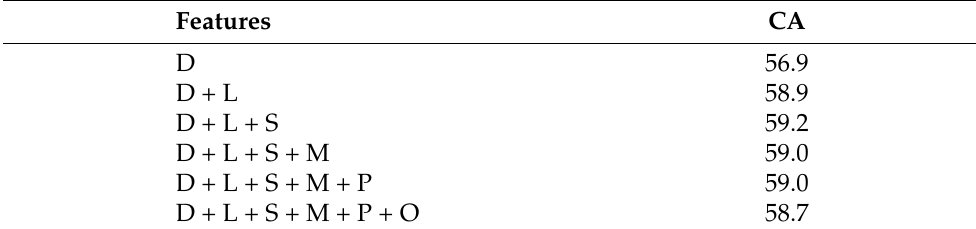
Table 3. Features and classification